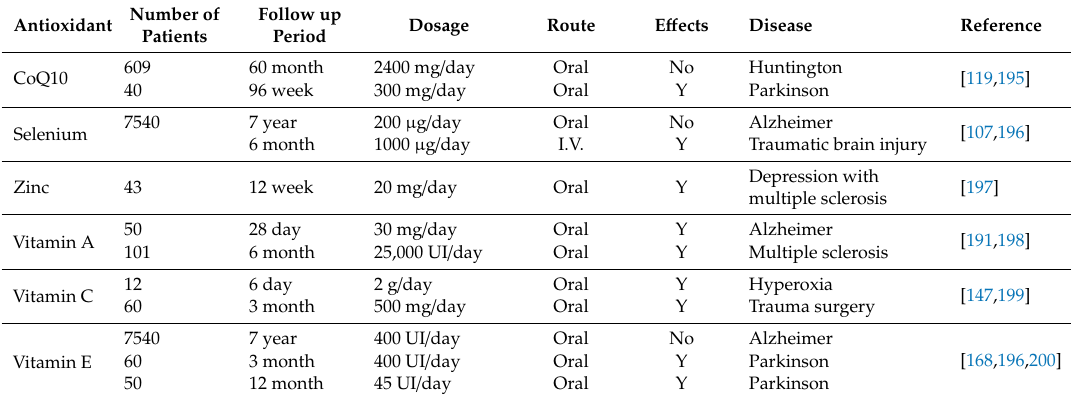
Table 1. Clinical trials of antioxidant in neurodegenerative diseases. Number of Antioxidant